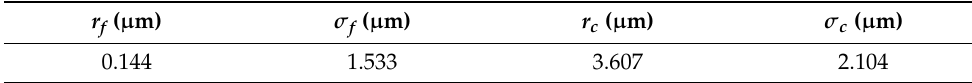
Table A1. Parameters of approximate form of Equation